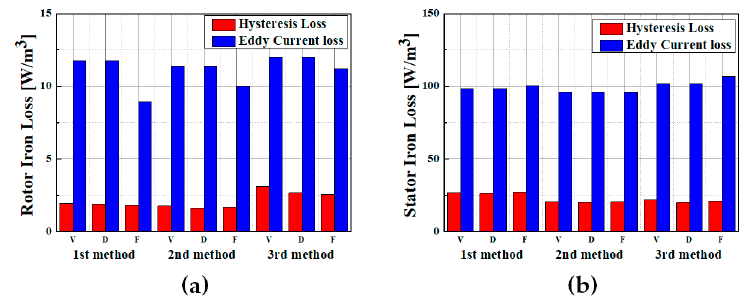
Table 3. Efficiency comparison of three different rotor structure at 6540 rpm, 24 A phase current based on three different type of iron loss.